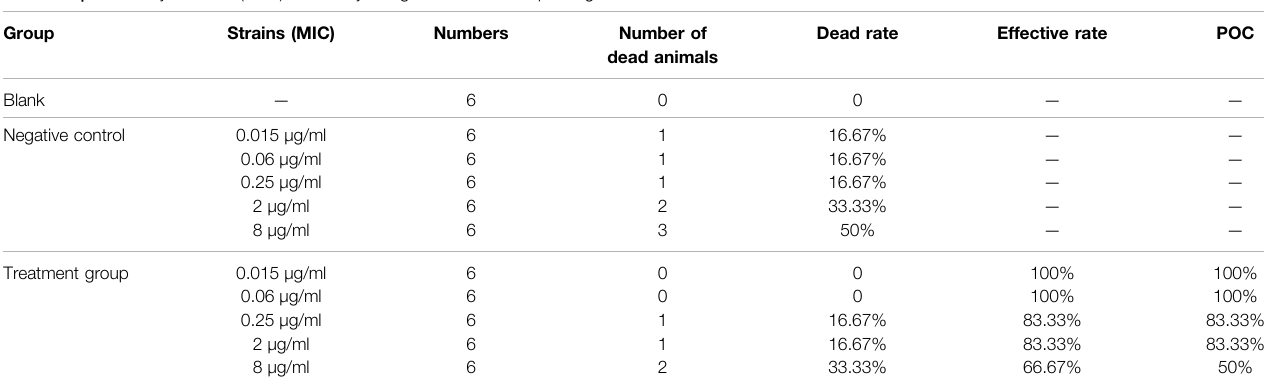
MIC, minimum inhibitory